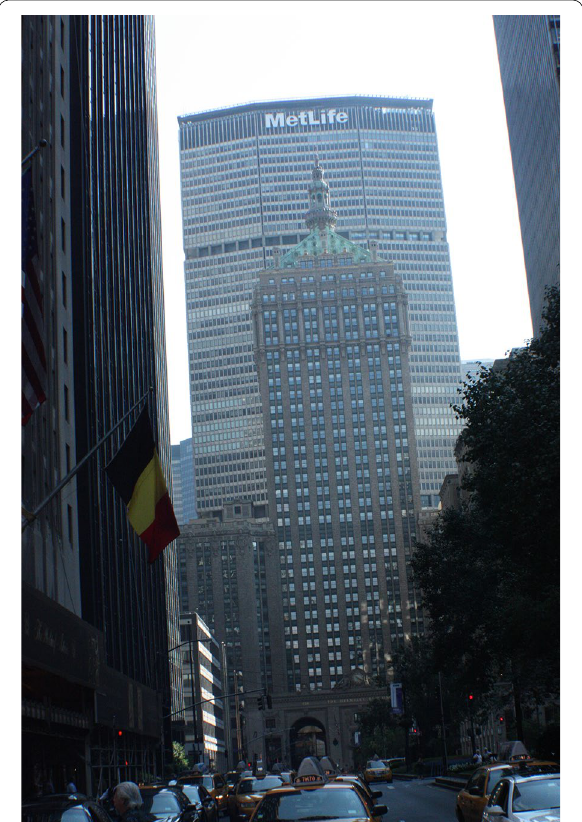
Fig. 24 The Aqua Tower in Chicago has a façade that mimics the ripples of the river